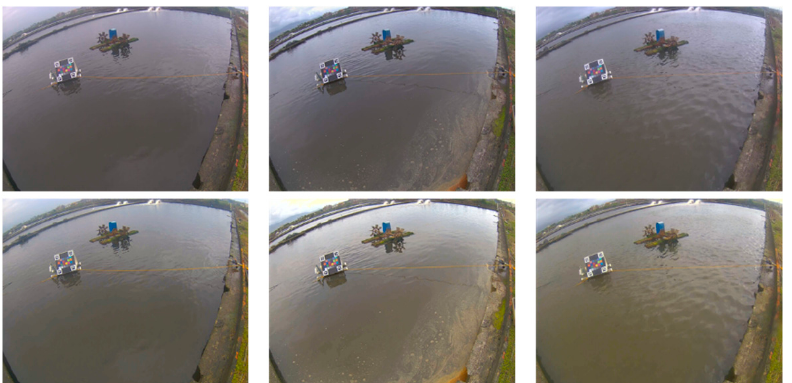
Figure 13. More results of color correction on site: original images (upper), and the color-corrected images (bottom).